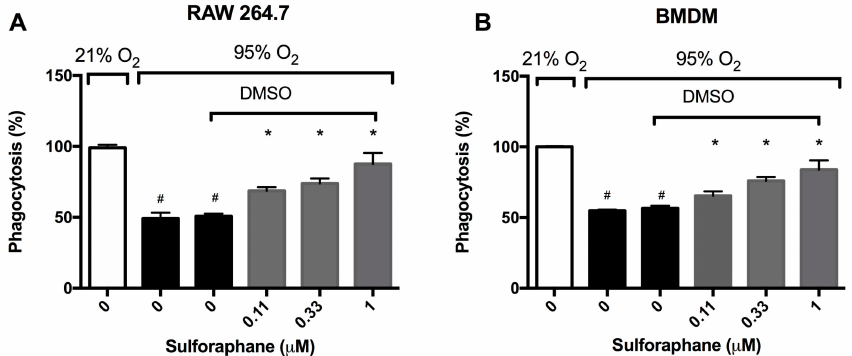
Figure 2. Sulforaphane (SFN) attenuates the hyperoxia-induced impairment of macrophage phagocytosis. RAW 264.7 cells ( A ) and BMDM cells ( B ) were exposed to 21% O 2 or 95% O 2 in the presence of increasing concentrations of SFN (diluted in DMSO as the vehicle) for 24 h and were then incubated with fluorescein isothiocyanate (FITC) labeled minibeads for 1 h. Cells were subsequently stained with DAPI and phalloidin to visualize the cells. Phagocytic activity was quantified by counting the number of minibeads in at least 200 cells per well. Data are presented as the mean ± SEM of the percentage of phagocytosed minibeads. The results were based on three independent experiments. # p < 0.05 compared to 21% O 2 control group. * p < 0.05 compared to 0 µ M SFN vehicle control